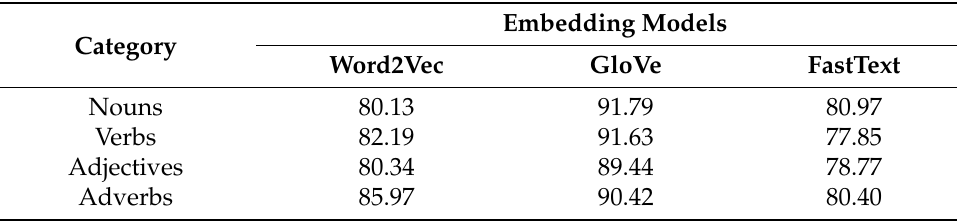
Table 6. Category-based Neighbourhood Percentage Accuracy of Tamil Embeddings.